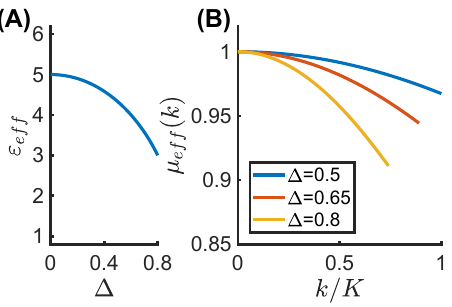
Figure 2: Effective parameters for the temporal metamaterial considered in Figure 1. as a function of Δ ; (B) effective (A) Effective relative permittivity 𝜖 eff ( k ) as a function of k ∕ K , for different values relative permeability 𝜇 eff of the modulation depth Δ . Note that 𝜇 ( k ) is only shown within the eff region where the nonlocal EMT holds ( ≲ 10 % error with respect to full-wave